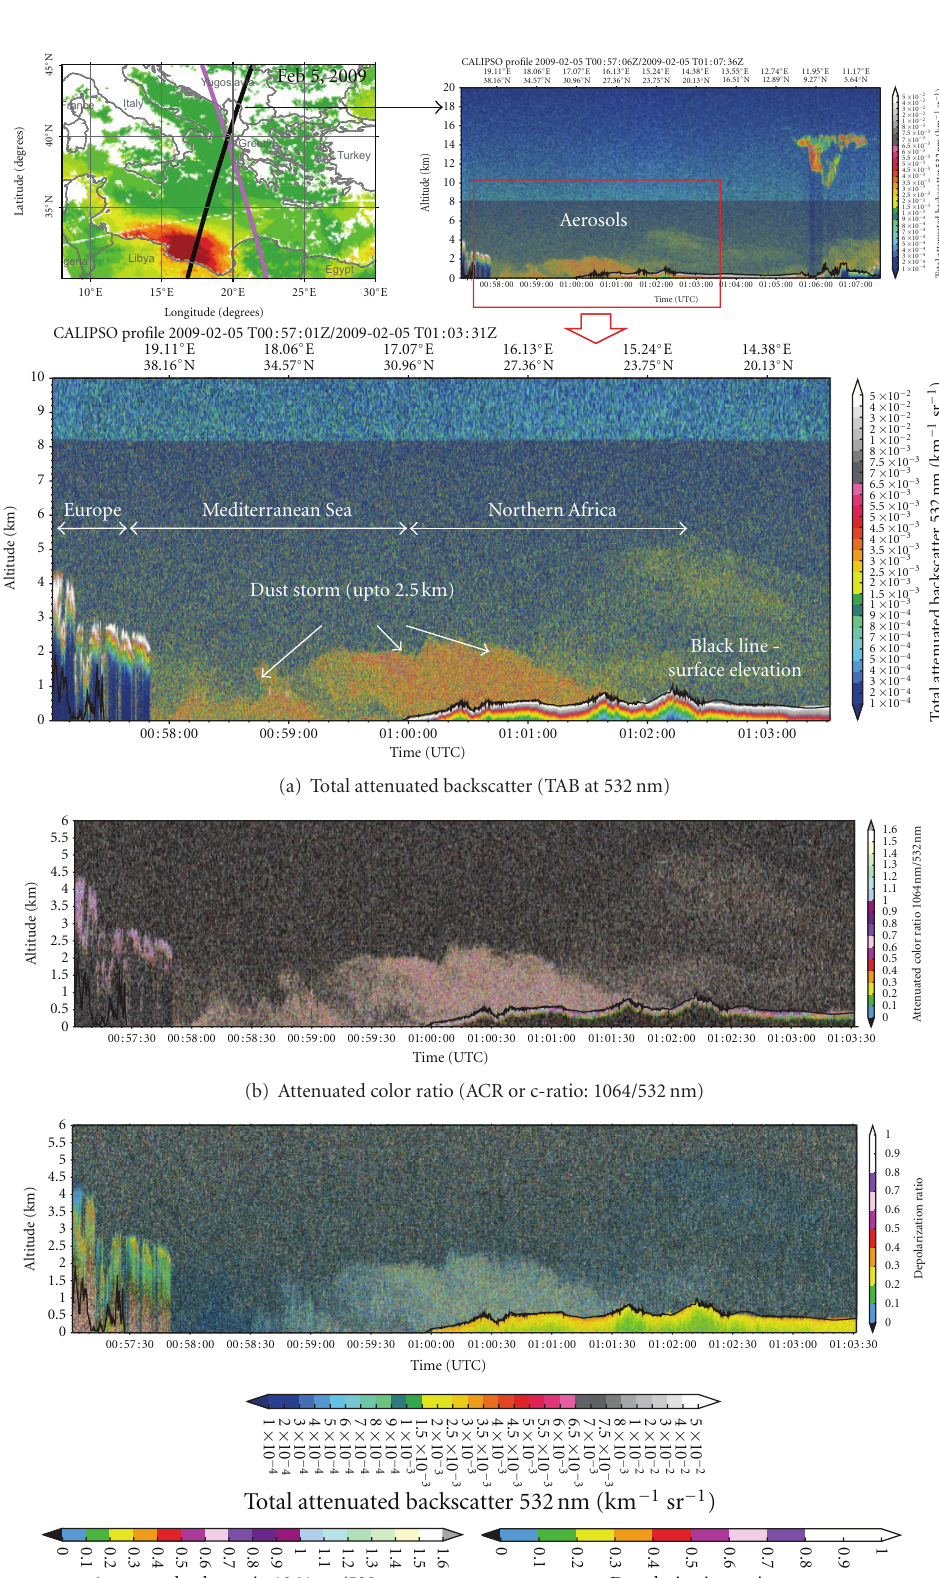
(c) Depolarization ratio (DR or d-ratio) show is its sensitivity towards the vertical measurement (0–5km) of desert dust during night Figure 6: The vertical profile of the atmosphere using CALIPSO night-time overpass over the Europe-Mediterranean Sea and northern Africa (Sahara desert) showing the presence of dust storm and its vertical extent. The multiple parameters from